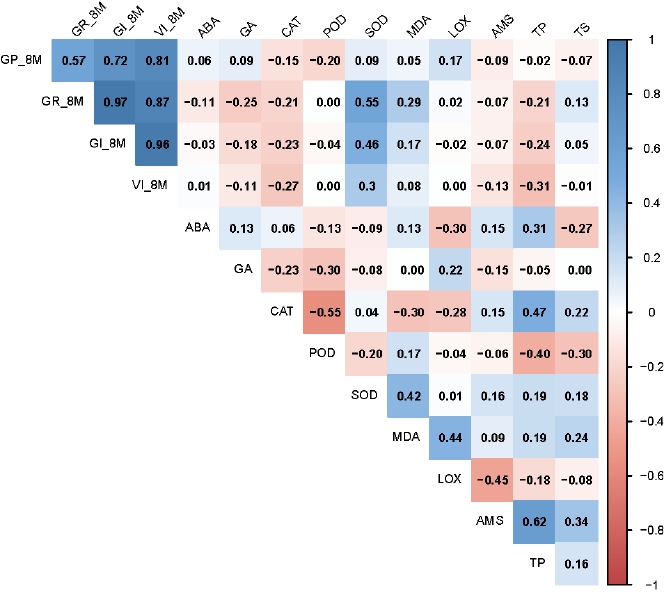
Figure 7. Correlation analysis of seed vigor indexes and physiological indexes in seeds subjected to natural aging.